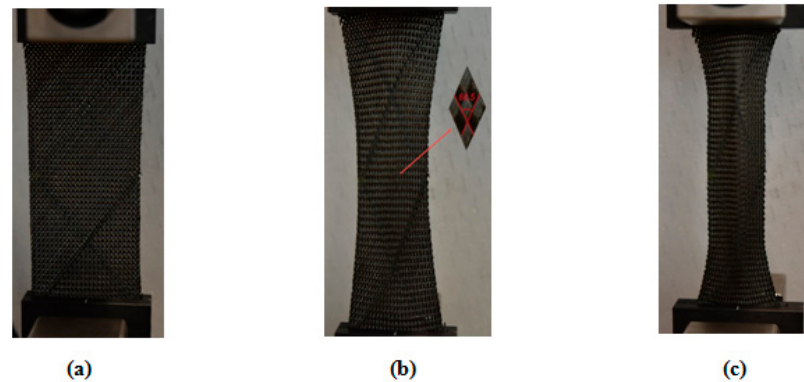
Figure 15. The PWCP ( a ) before shear deformation; ( b ) at the onset of locking ( γ = 28.7 ± 0.8 ◦ ); ( c ) at the onset of wrinkling ( γ = 38 ± 0.5 ◦ ).